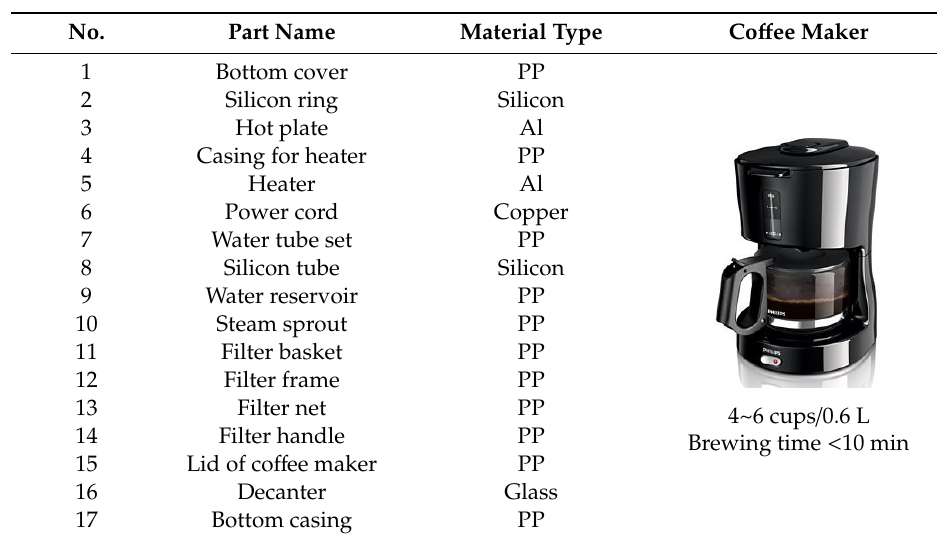
Table 2. Specification of the co ff ee maker.